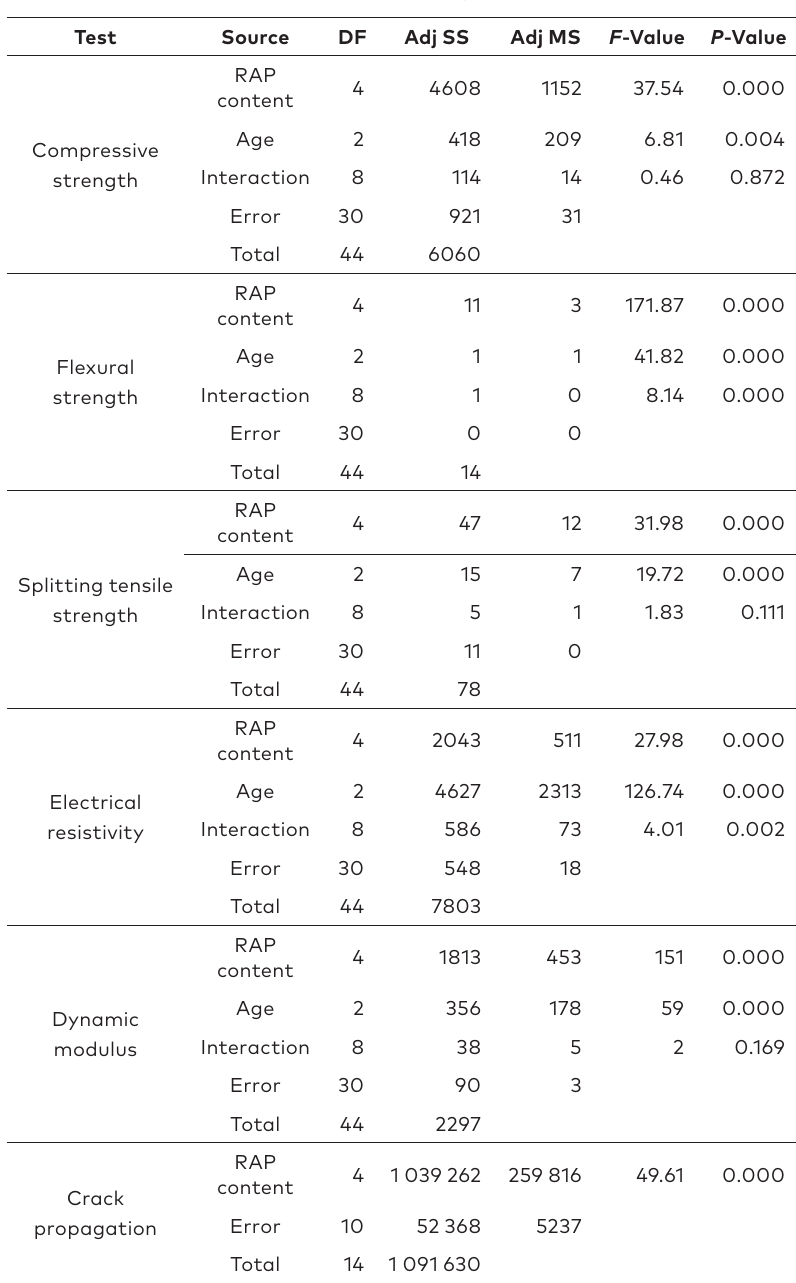
Table 5. Analysis of variance of the test